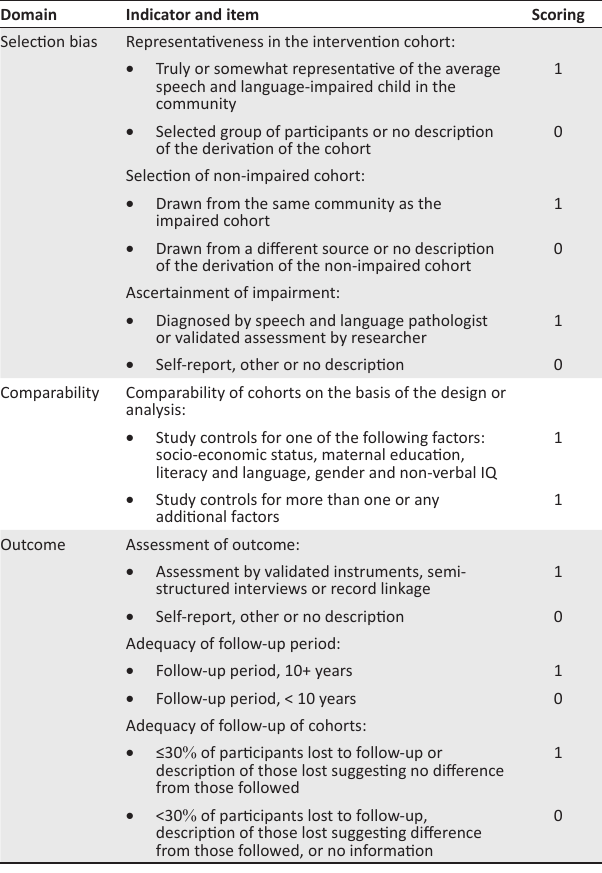
TABLE 1-A1: Modified Newcastle–Ottawa scale for assessing the quality of included studies. Domain Indicator and item Scoring Selection